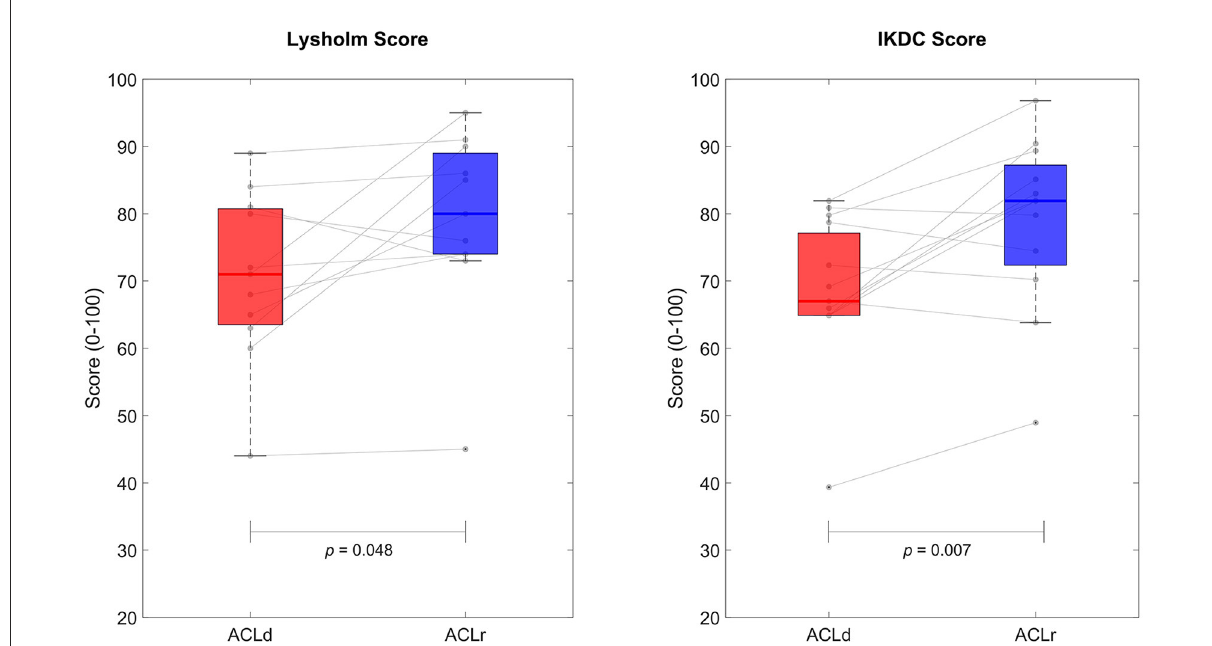
FIGURE1 Perceived knee function based on Lyshold and International Knee Documentation Committee (IKDC) scores. Both measures showed statistically significant improvement from pre to post ACL